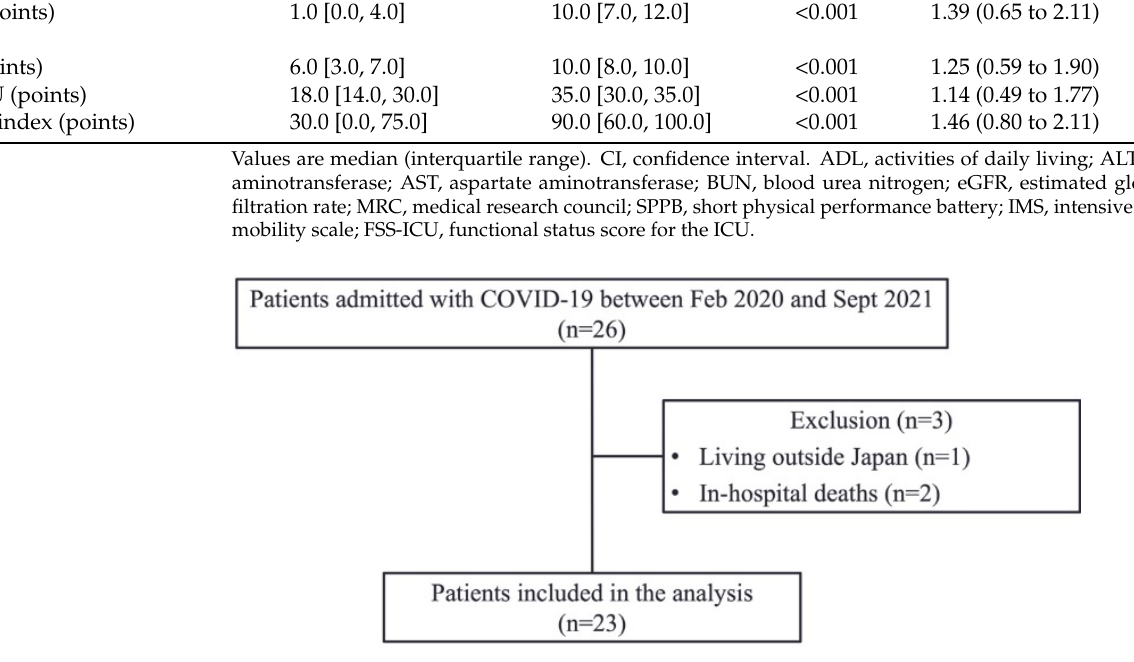
Figure 1. Flow diagram of this study.